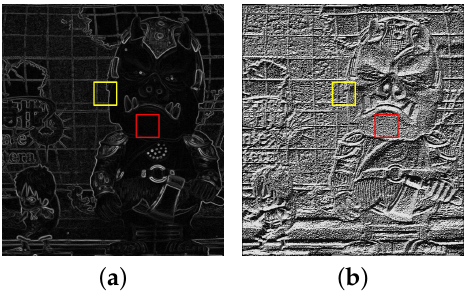
Figure 7. Comparison of the gradient magnitude and LBP feature: ( a ) two blocks selected in gradient magnitude image and ( b ) LBP feature